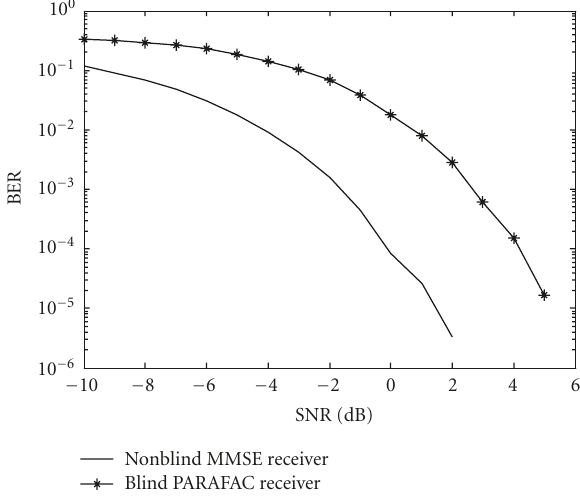
Figure 3: The algorithm performances comparison with N = 400.